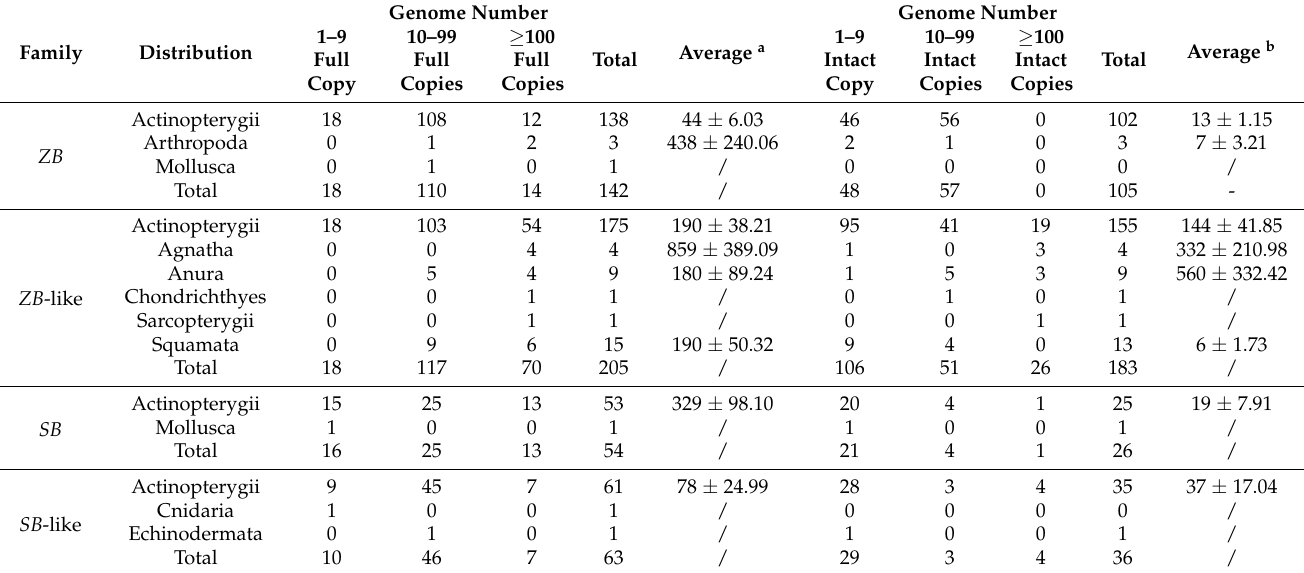
Table 2. Full and intact copy numbers of ZB and SB transposons in